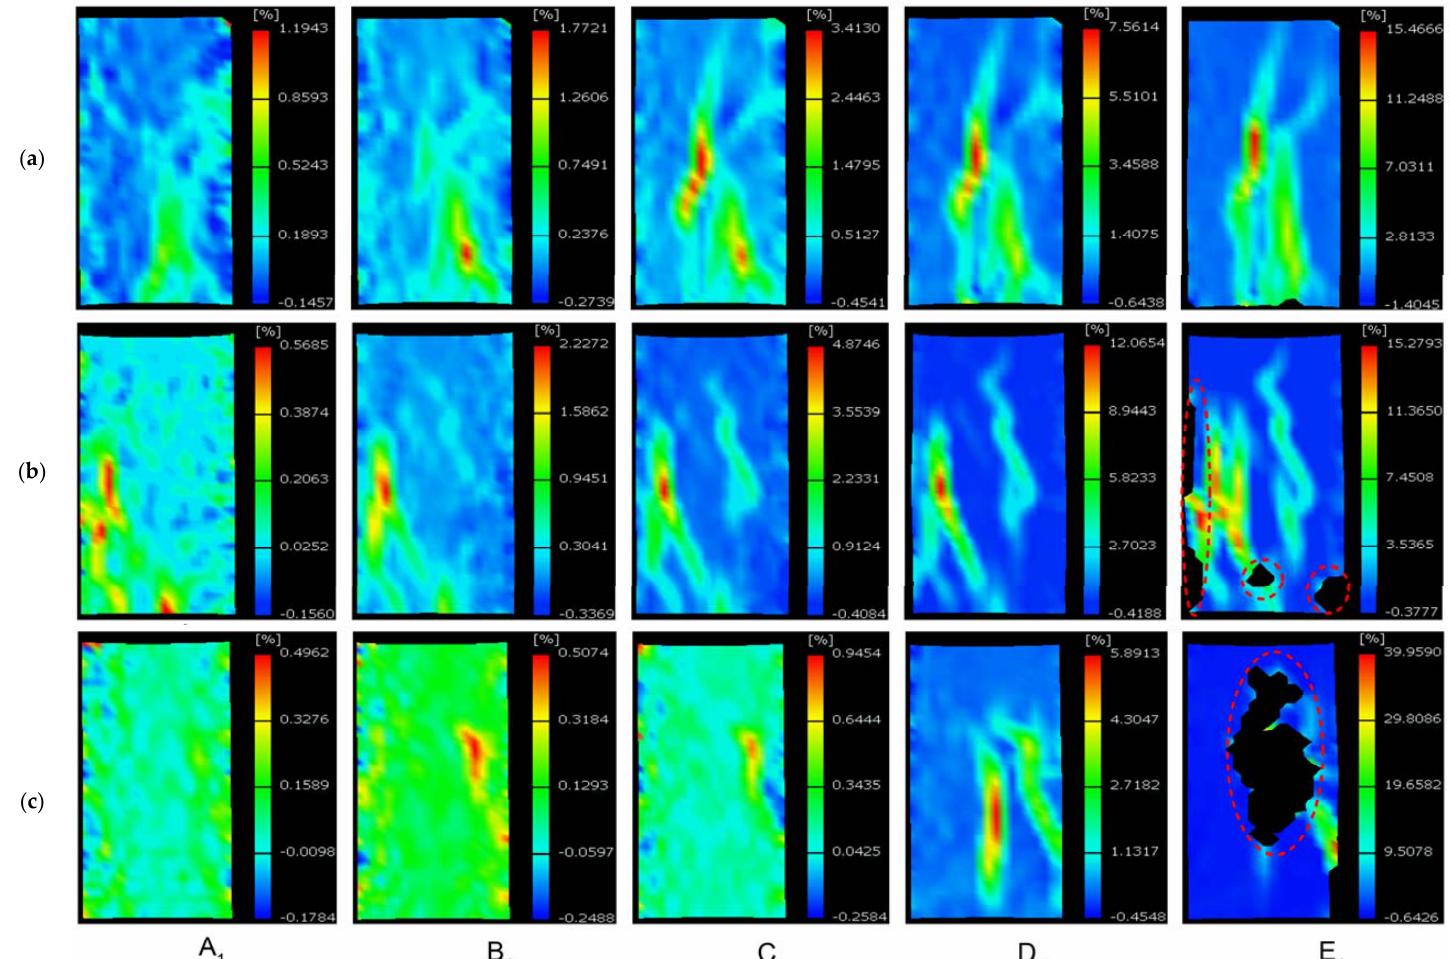
Figure 5. The major strain fields obtained by ( a ) L1; ( b ) L2; ( c ) L3 in uniaxial compression.